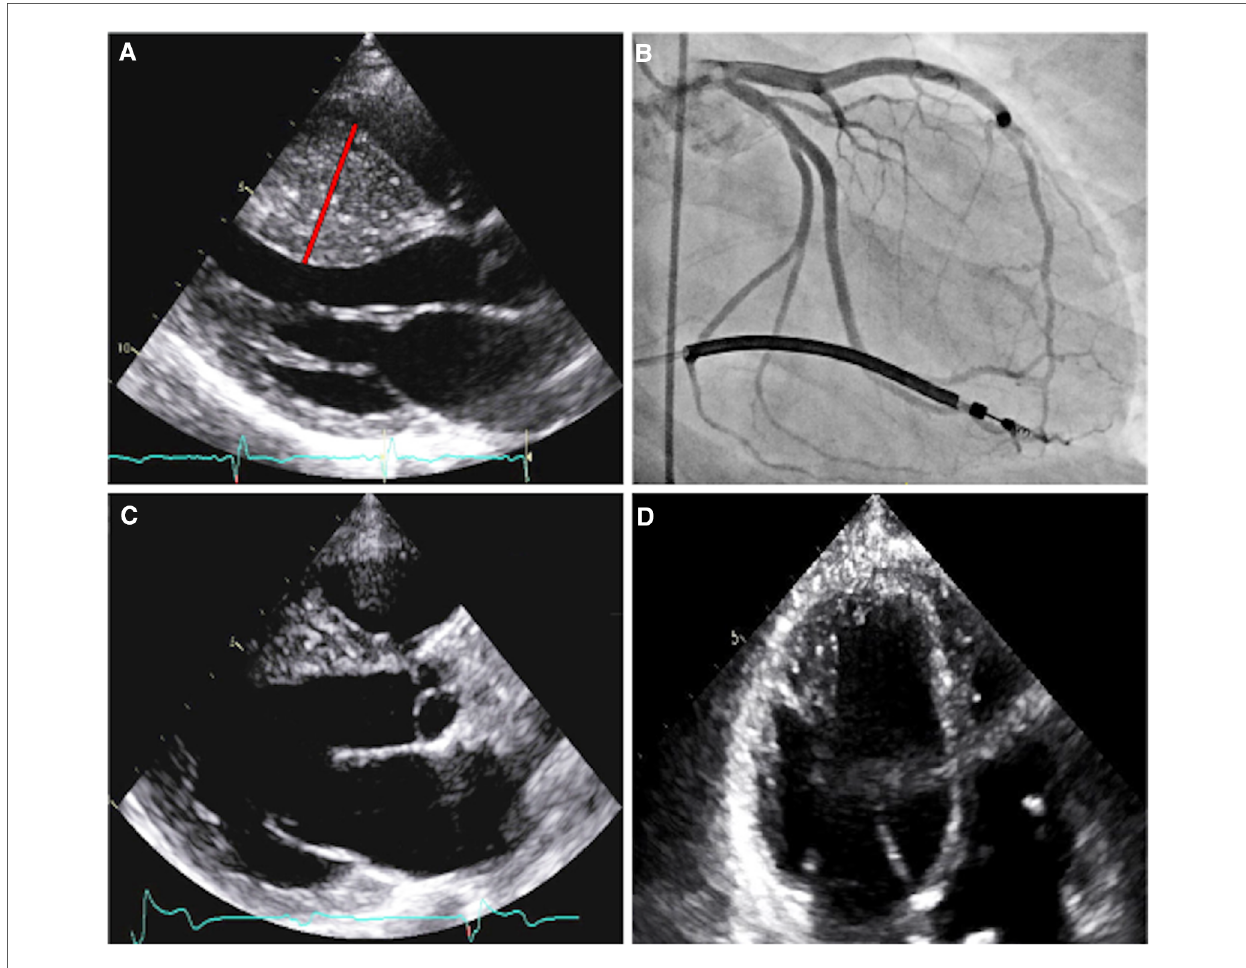
FIGURE 2 Imaging of patient A. Parasternal long axis echocardiogram prior to septal myectomy ( A ). The interventricular septum has reverse curve morphology, with a septal thickness measurement of 33 mm (red line) during diastole and a patent left ventricular out fl ow tract. Right anterior oblique caudal angiogram with prominent myocardial bridging of the large fi rst and second septal perforators ( B ). Parasternal long axis echocardiogram, status-post septal myectomy ( C ). Four-chamber echocardiogram, with increased apical cavity size following septal myectomy ( D